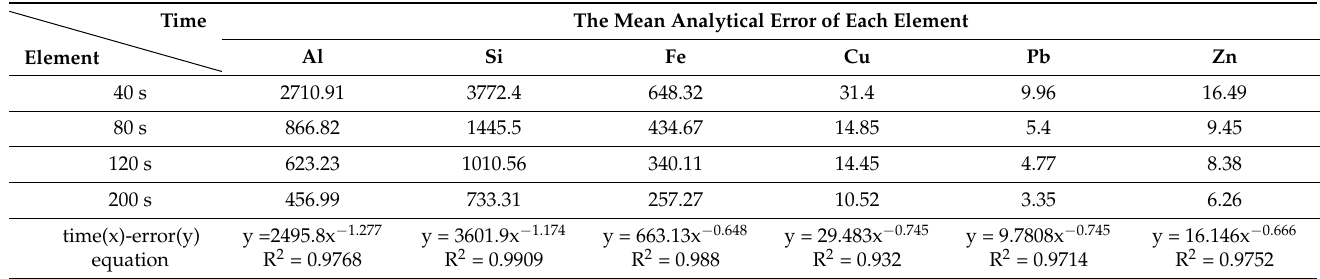
Table 2. The relationship between detection time and mean analytical error.